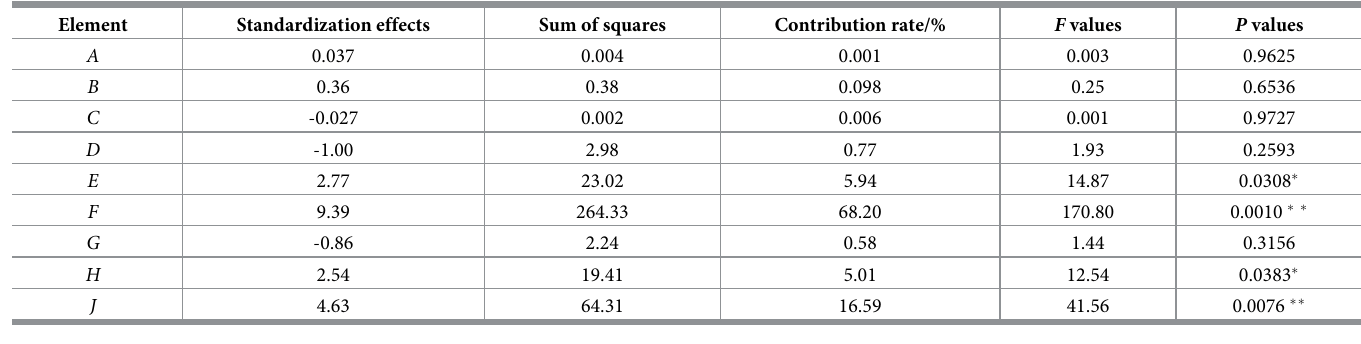
Note �� represents extremely significant influence (P < 0 . 01)